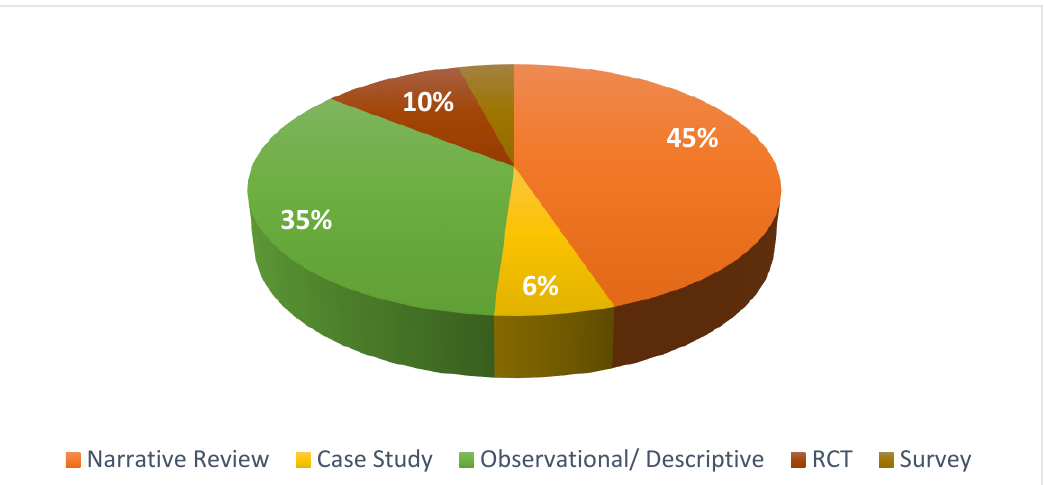
Figure 2. Type of studies included in the data set. RCT: randomized control trial.